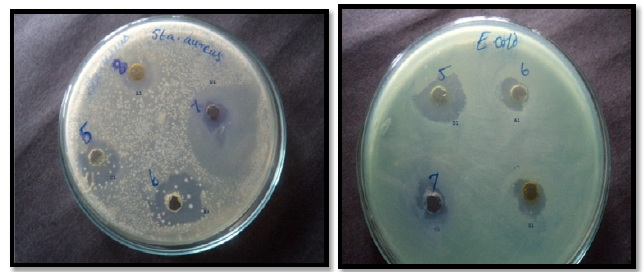
Fig. 10. Antibacterial activity of ZnO, Co-ZnO, Cu-ZnO and (Co, Cu)/ ZnO Nps against Staphylococcus aureus and Escherichia